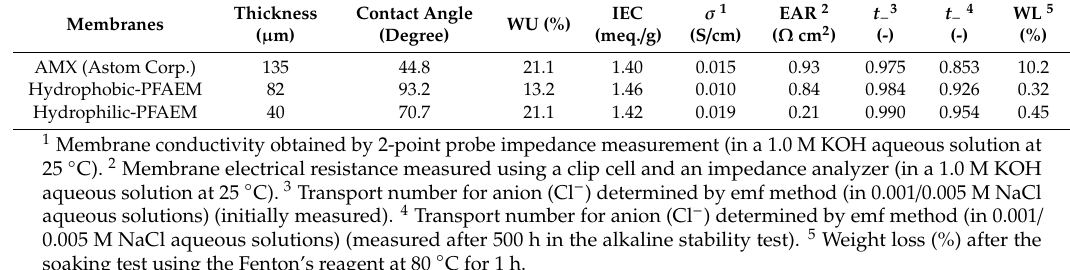
Table 2. Various characteristics of commercial and prepared membranes. Thickness Membranes ( µ